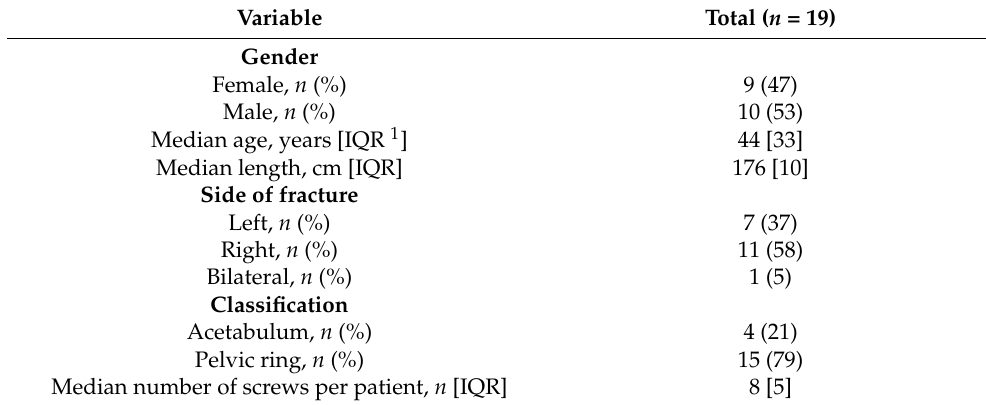
Table 1. Patient characteristics.